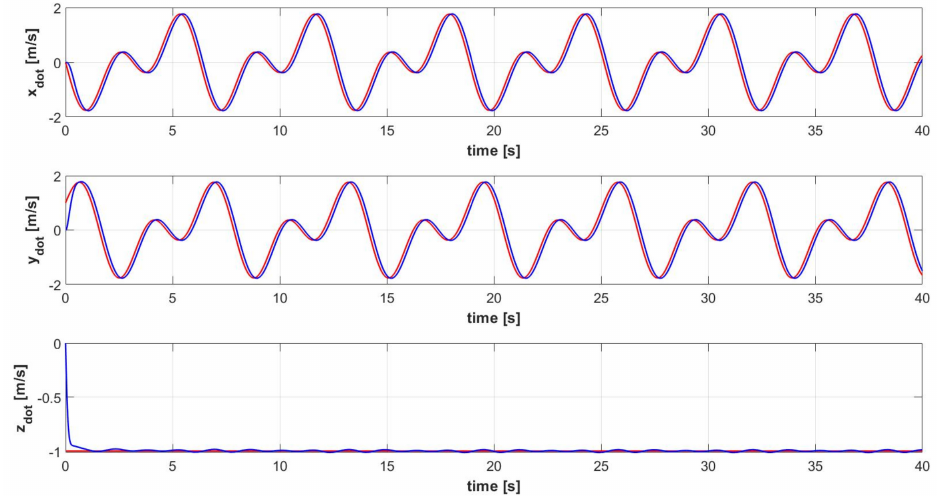
Figure 13. Velocity signals [ X (cid:48) ( t ) , Y (cid:48) ( t ) , Z (cid:48) ( t ) ] of the controlled quadrotor system (blue) and reference velocity signals of trajectory 2 (red).